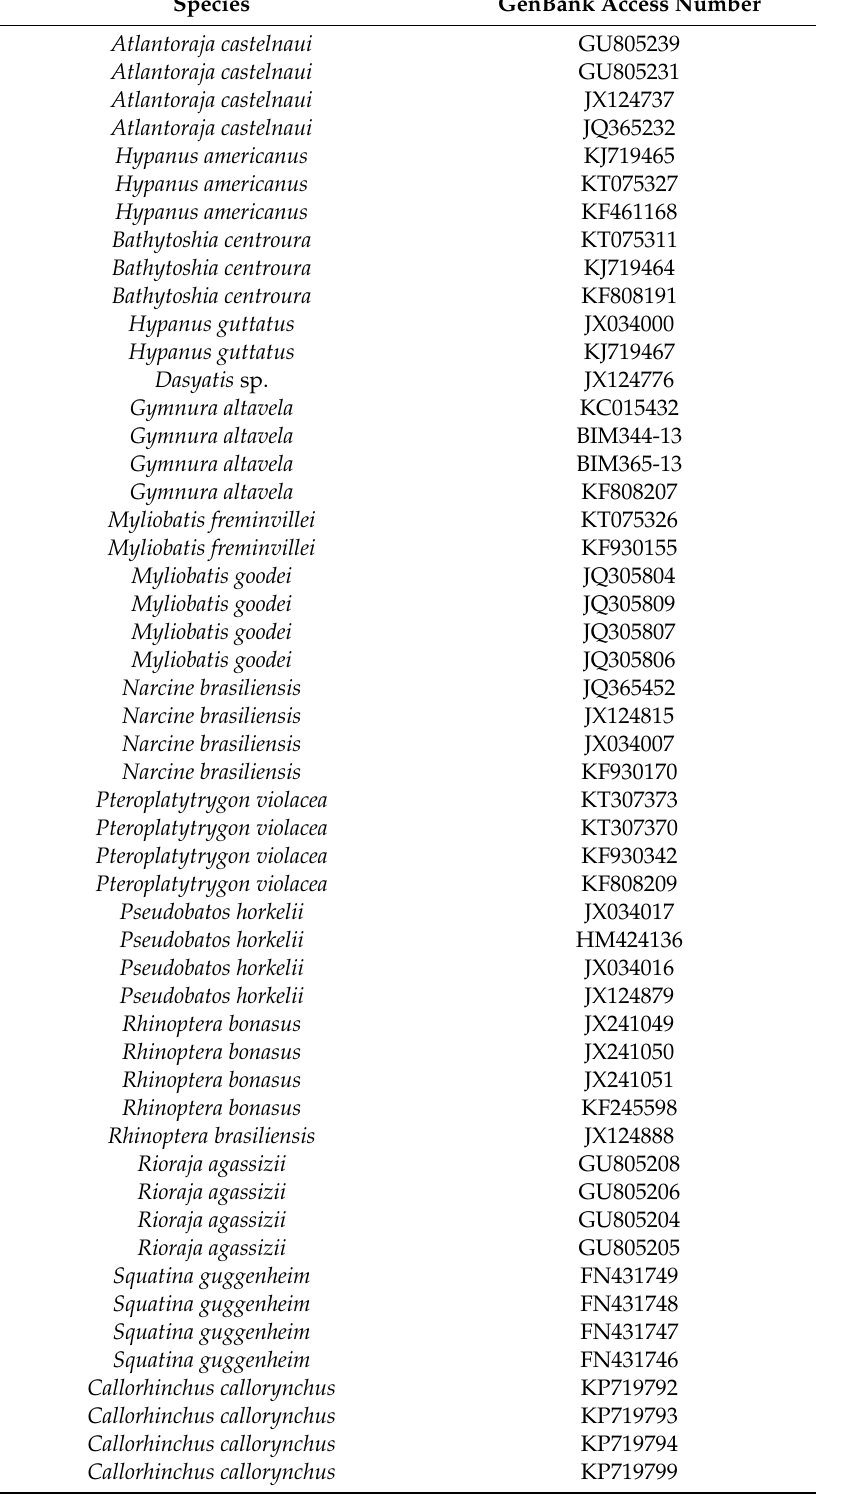
Table A1. GenBank sequences utilized for the construction of the phylogenetic tree with barcode index numbers (BINs) of the identified